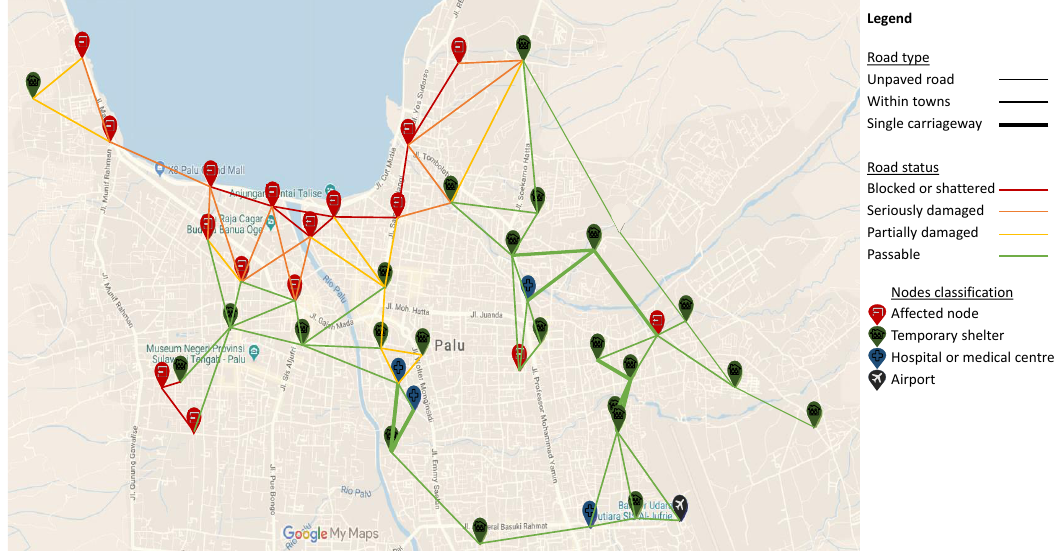
Figure 3. Complete